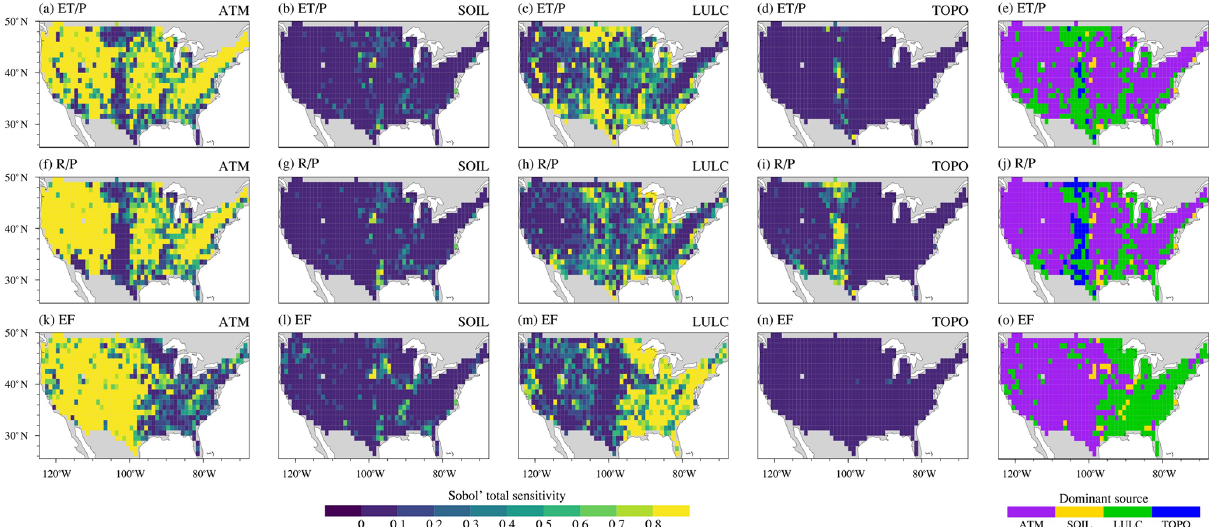
Figure 5. Spatial patterns of Sobol’ total sensitivity index for the four heterogeneity sources (column one–four) and the corresponding dominant sources (column five) for the spatial variability of water (ET /P and R/P ) and energy (EF) partitioning.